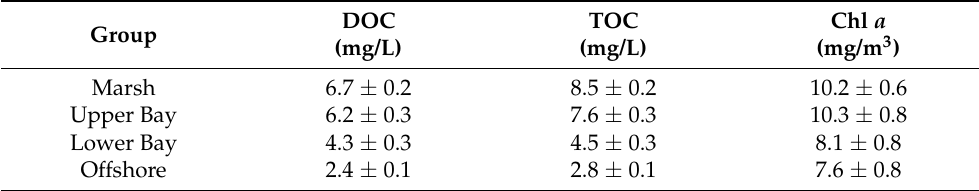
Table 4. Mean values ( ± s.e.) of dissolved organic carbon (DOC), total organic carbon (TOC), and chlorophyll a (CHL a) for the year in Caminada and Barataria bays (modified from [66]; data collected November 1971 to November 1972).